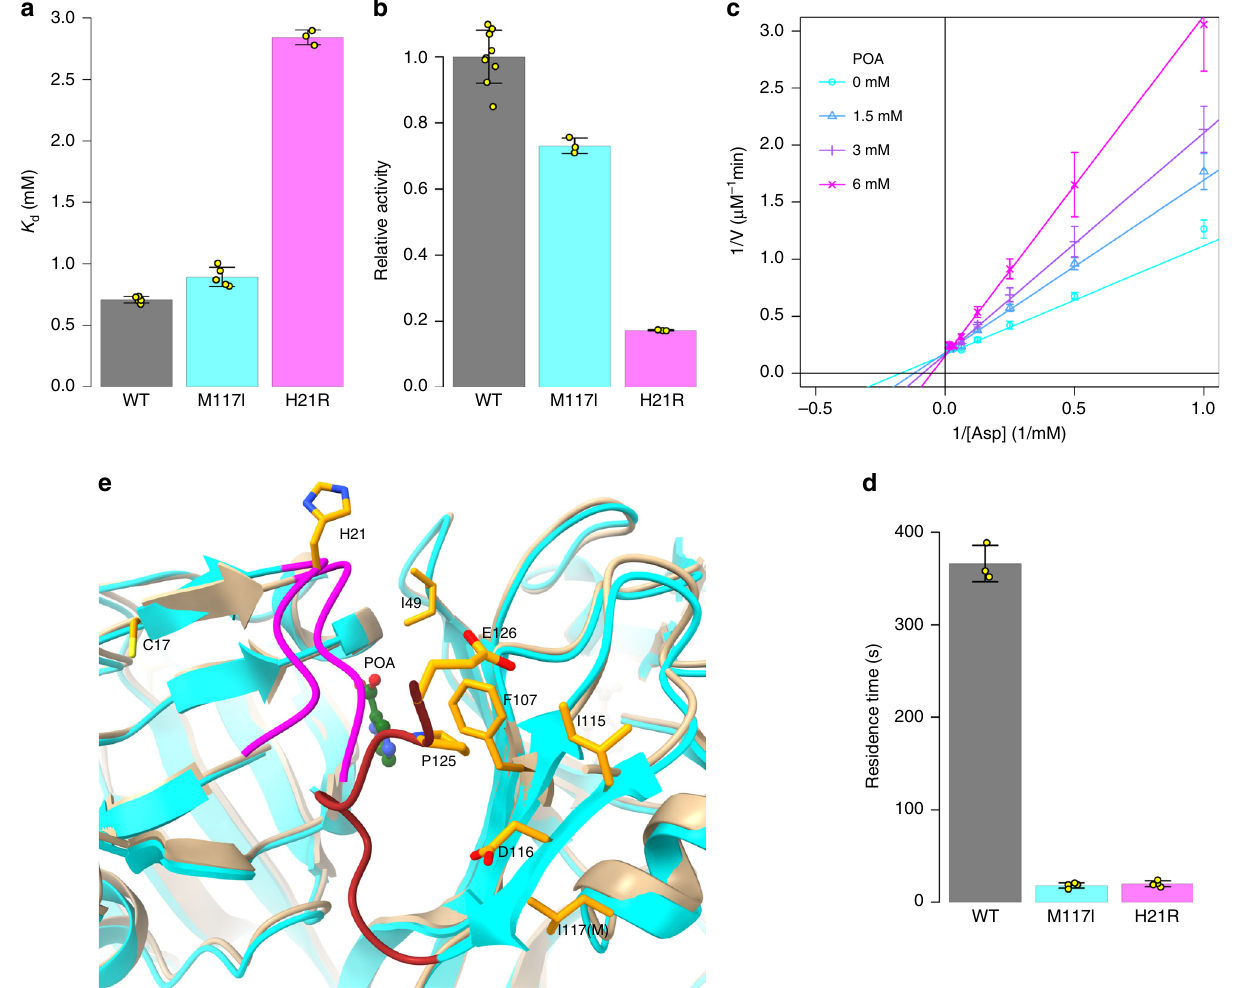
Fig. 3 POA r mutations on Mtb PanD. a H21R showed resistance to POA. Lineweaver – Burk plots of H21R activity in the presence of various concentrations of POA prepared separately in quadruplicate. The data were fi tted with a competitive inhibition model, yielding K i = 3.0 (0.1) mM, K M = 5.5 (0.2) mM, and k = 0.184 (0.003) s − 1 . b The relative enzyme activity of Mtb PanD proteins. The aspartate concentration was 1 mM in the assay. c The af fi nity of Mtb cat PanD:POA was measured with ITC. POA at 40 mM was titrated into 0.5 mM H21R PanD, while 20 mM POA was used in the wild type and M117I